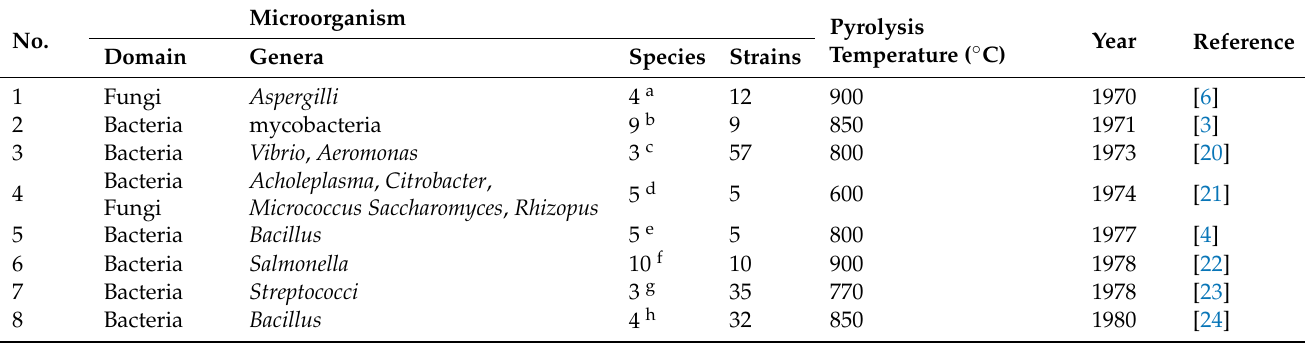
Table 2. Reported pyrolysis temperatures for discrimination of microorganisms by PyGC.